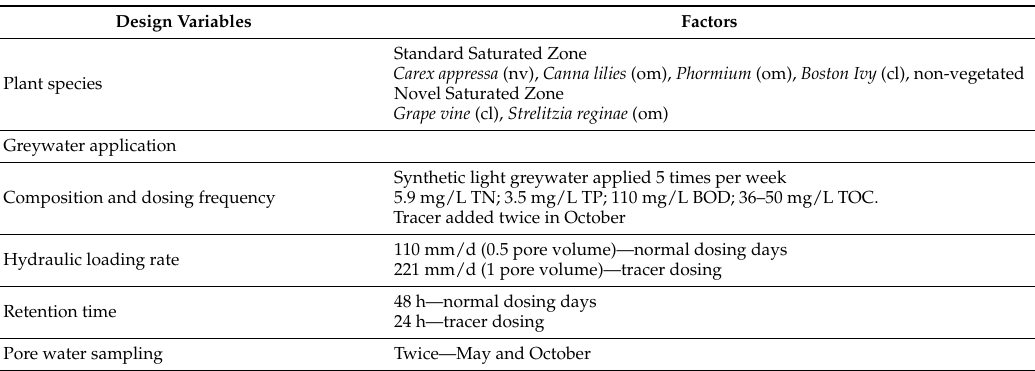
Table 1. Summary of experimental